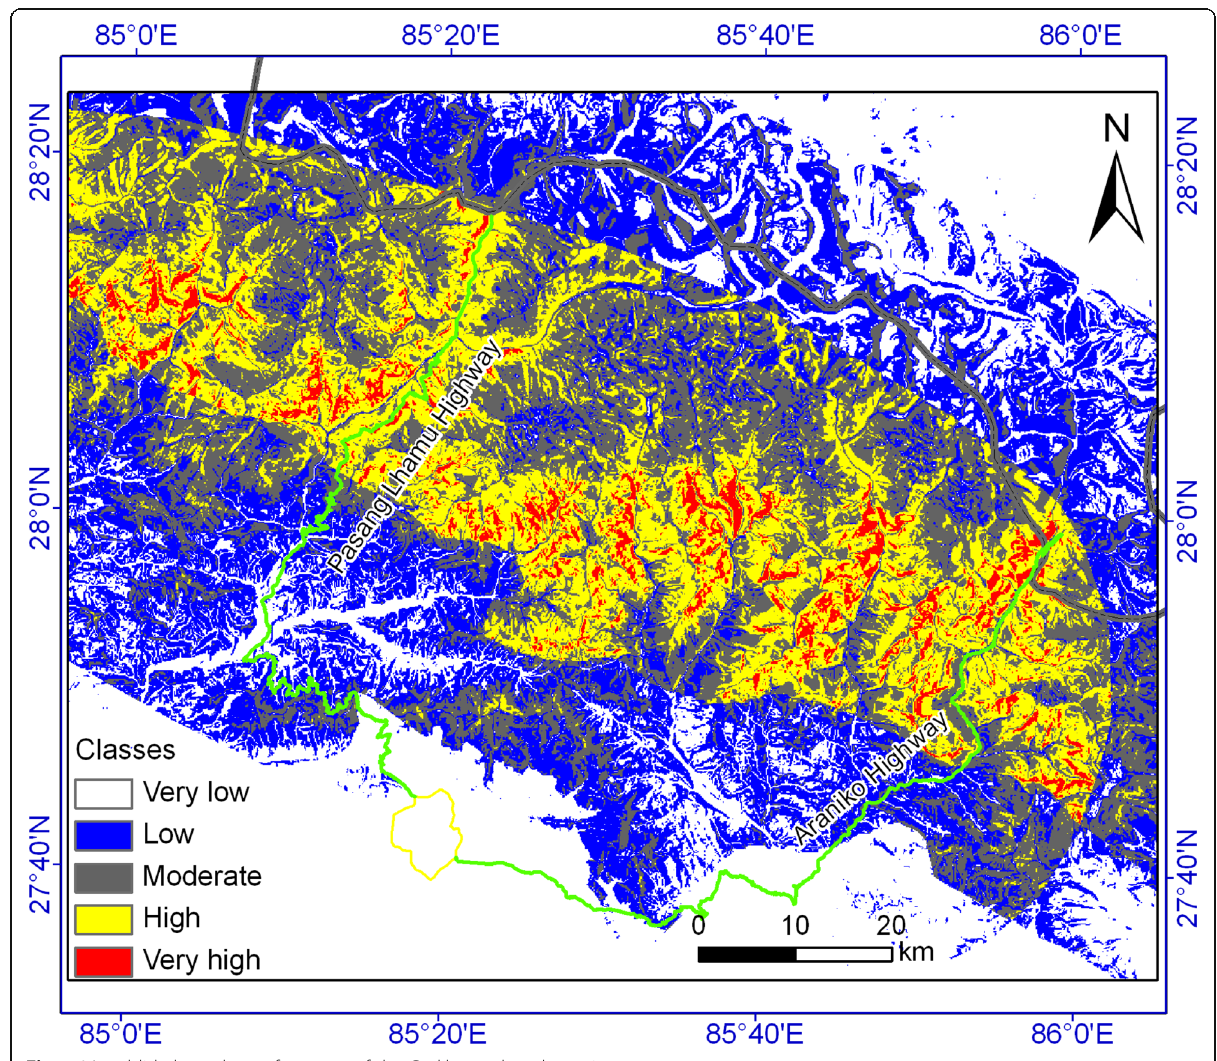
Fig. 16 Landslide hazard map for a part of the Gorkha earthquake